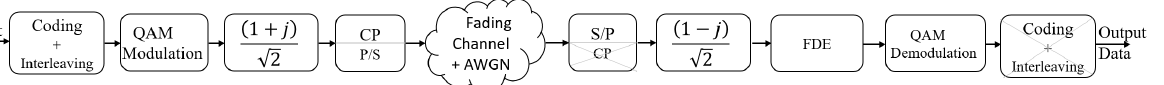
Figure 1. System model for DHT precoded OFDM transmission showing the elimination of DHT-IDFT complexities. Note that PS implies parallel-to-serial conversion; similarly, SP represents serial-to- parallel